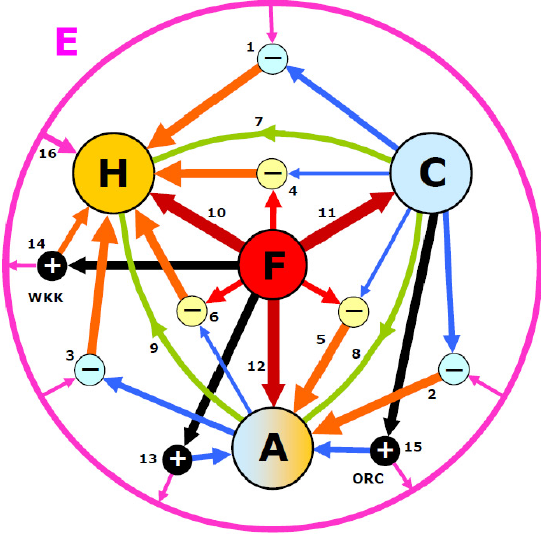
Fig. 2. – Energy circle